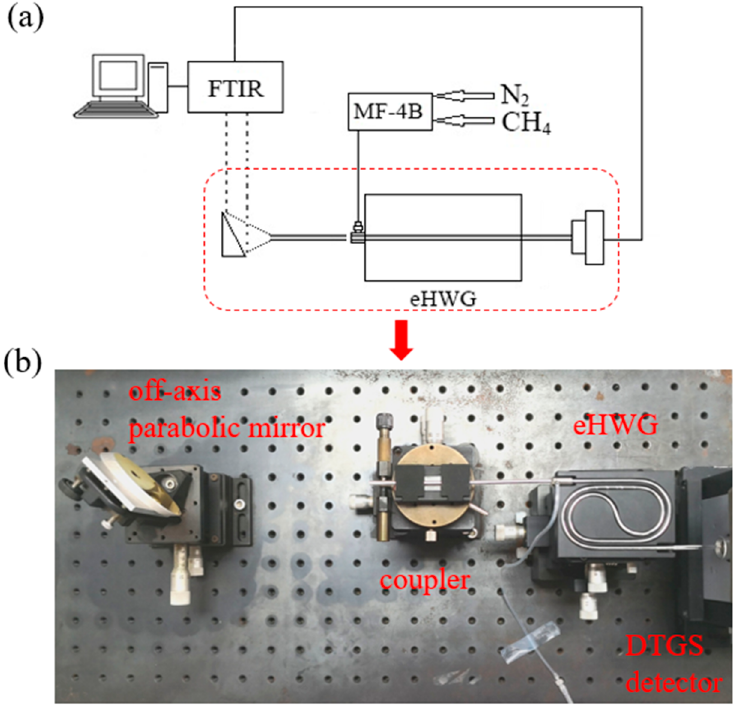
Figure 3. ( a ) Diagram of the sensing system. ( b ) Picture of light coupling, gas let in at the coupling end, gas let out at the distal end, and the detector for the eHWG.